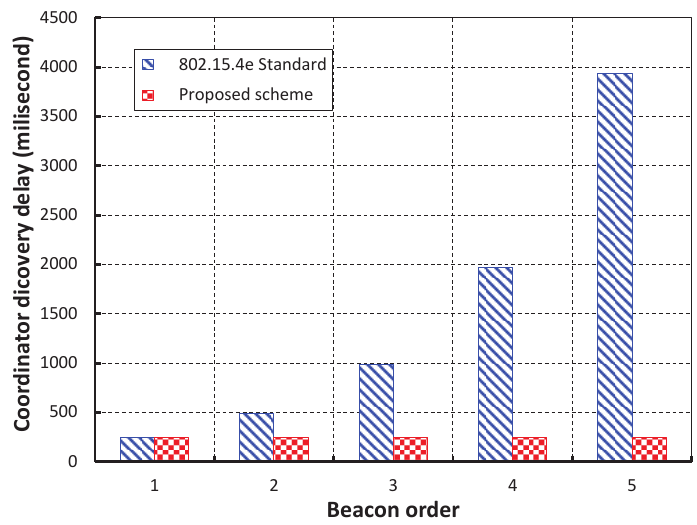
Figure 15. Comparison of minimum coordinator discovery delay of our proposed scheme with the IEEE 802.15.4e standard.